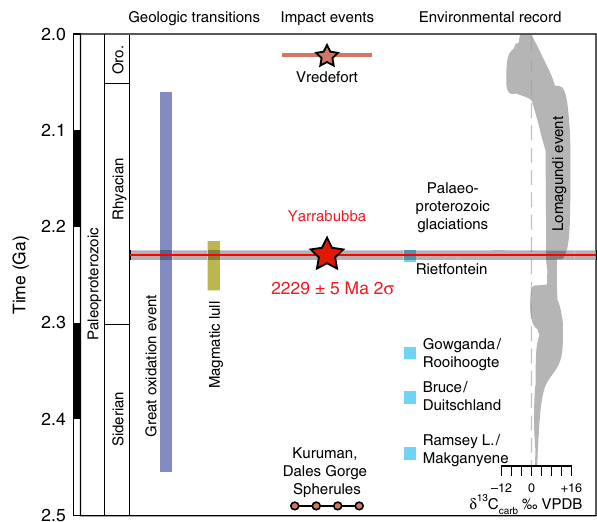
Fig. 4 Temporal evolution of the early Palaeoproterozoic Earth.